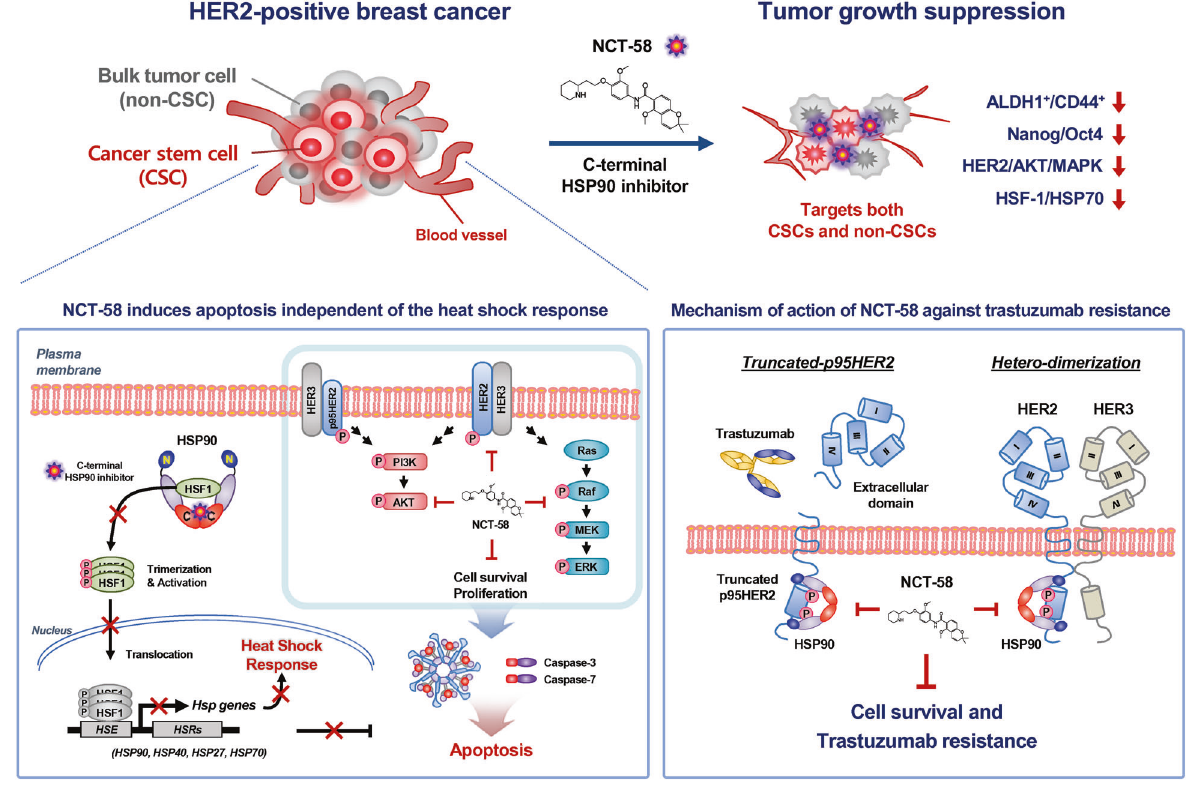
Fig. 7 Hypothetical model illustrating multiple actions of NCT-58 on cancer stem-like properties, HER2 signaling, and trastuzumab resistance in HER2-positive breast cancer. i NCT-58 targets the C-terminal domain of HSP90 independent of the HSR and effectively induces apoptosis via the activation of cleaved caspase-3/7. ii NCT-58 downregulates the expression and phosphorylation of HER2, HER3, and EGFR as well as suppresses truncated p95HER2 accumulation and Akt activation, concomitant with downregulation of the Ras/Raf/Mek/Erk signaling pathway. iii NCT-58 kills not only proliferating tumor cells, but also eliminates BCSC-like cells. The latter responses are accompanied by the reduction of stem/progenitor markers CD44/ALDH1 and expression of the pluripotent transcription factors Nanog/Oct4/Sox2 as well as downregulation of HSF-1/HSF70/HSP90. [Heat shock response, HSR; Heat shock factor-1, HSF-1, Heat shock element,